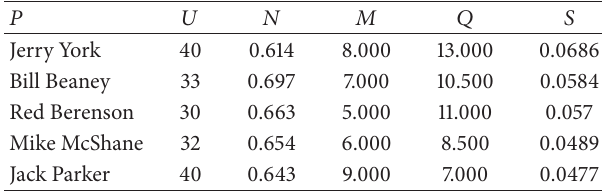
Table 15: Comparison of priority